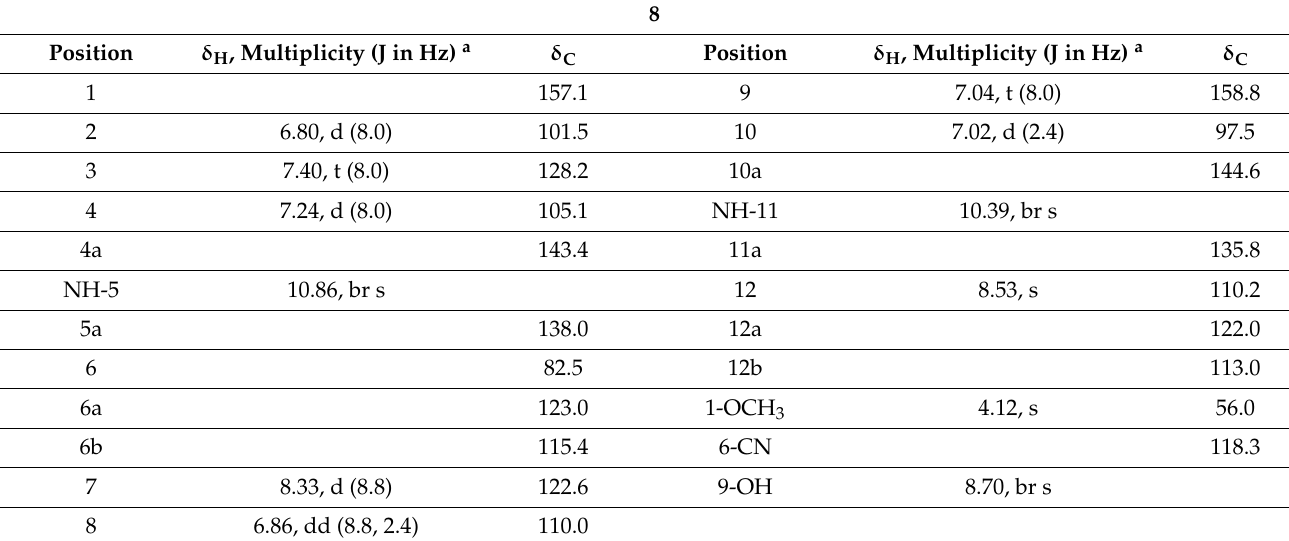
Table 4. 1 H- and 13 C-NMR data for compound 8.